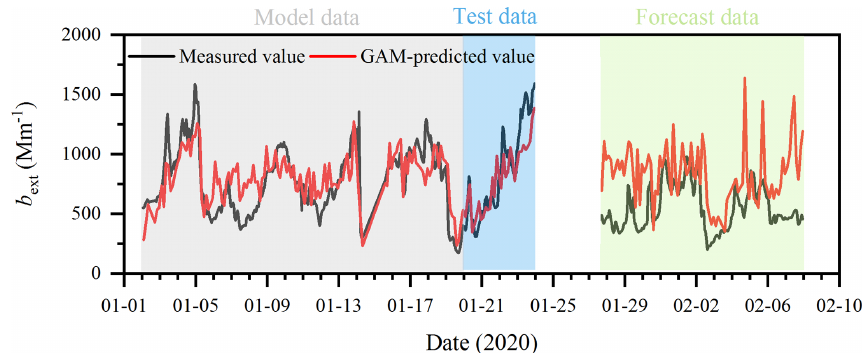
Figure 3. Time series of the measured and GAM-predicted light extinction coefficient ( b ext ) values for the model data, test data, and forecast